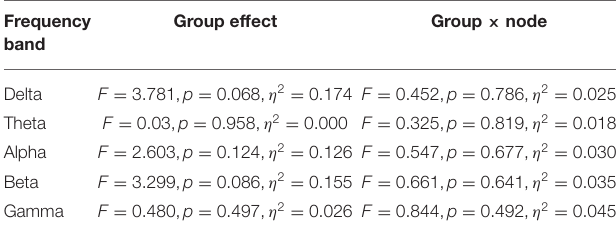
TABLE 2 | Assessment of relative powers in each frequency band comparing high- and low-creativity groups: results of mixed-design ANOVA. Frequency Group effect band